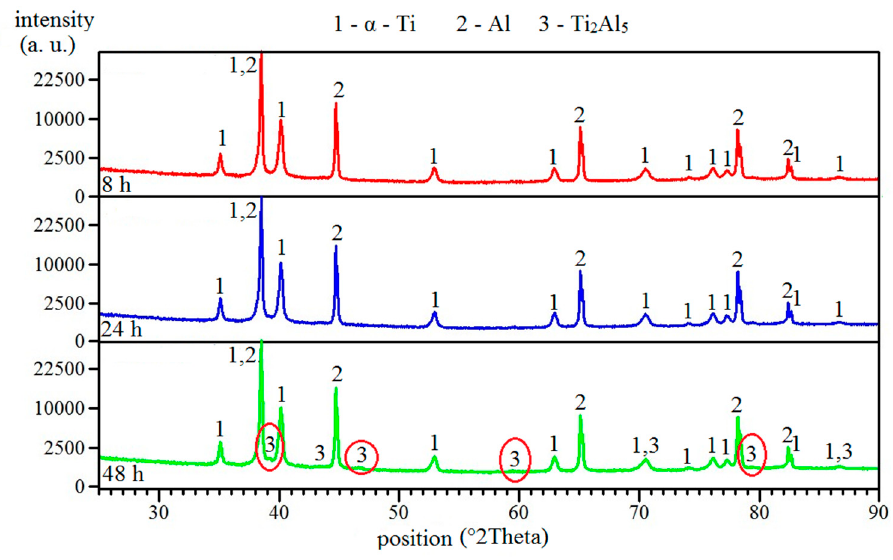
Figure 5. The XRD patterns of TiAl63 alloys annealed at 450 °C for 8, 24, and 48 h.